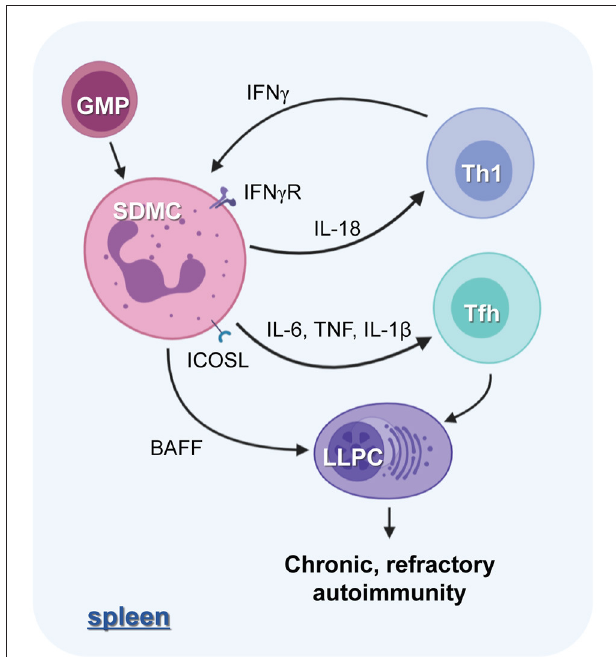
FIGURE 8 | The role of SDMCs in lupus autoimmunity. The proinflammatory cytokine milieu of the spleens of disease-established sanroque mice promotes the in situ expansion and pathologic activation of SDMCs. The SDMCs promote the development of Th1 and Tfh cells. Th1 cells, in turn, exert positive feedback on the emergence of SDMCs, and the Tfh cells are required for the development of long-lived PCs (LLPCs). SDMCs directly support the maintenance of LLPCs by providing BAFF, and the LLPCs cause the disease to be chronic and refractory to cytostatic treatments.